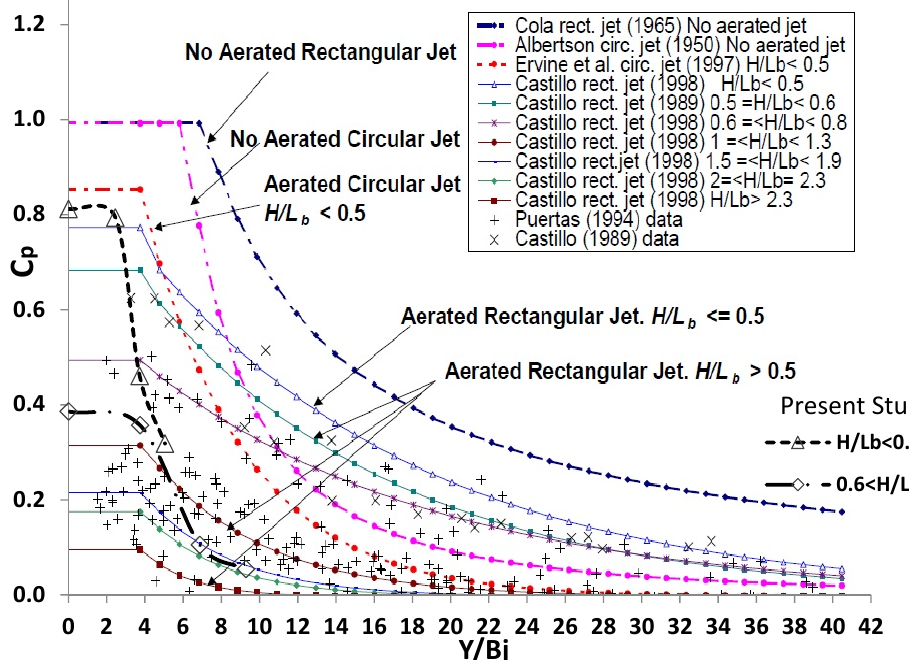
Figure 5. Comparison between correlation of Y / B j and C p in present research and previous works (reported by Castillo [19]).